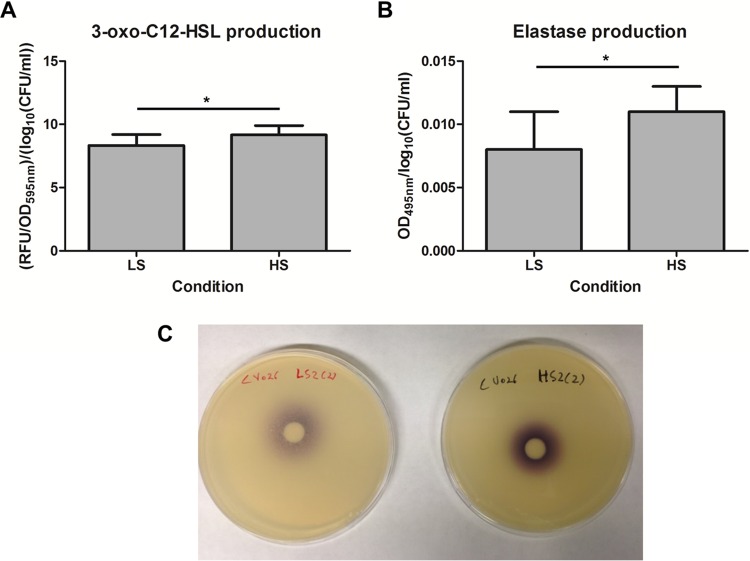
Production of QS molecules and elastase during growth under different shear stress conditions. (A) 3-Oxo-C12-HSL production. (B) Elastase production. (C) Production of short-chain (C4-C8) AHL molecules by P. aeruginosa CF_PA39 grown under low fluid shear (plate shown on the left) or high fluid shear (plate shown on the right) conditions. The picture shown here is representative of the results from all three technical replicates of each biological replicate. LS, low fluid shear. HS, high fluid shear. RFU, relative fluorescence units. *, P < 0.05.